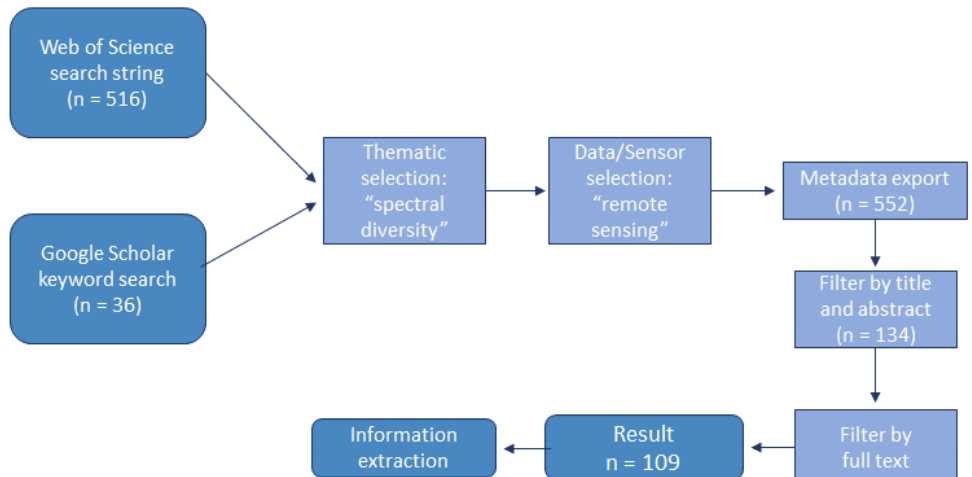
Figure 2. Workflow chart of the literature search process to identify relevant scientific articles about forest biodiversity monitoring from remotely sensed spectral diversity. An initial pool of publications collected in Web of Science ( n = 516) was supplemented by findings from a full text keyword search in Google Scholar ( n = 36). After screening the title, abstract and keywords of each article, 134 relevant articles remained. In a next step, the remaining articles were carefully read and relevant attributes extracted, excluding another 25 articles mostly because the study site did not cover forest areas. The final number of relevant articles considered in this review amounts to 109 articles published since